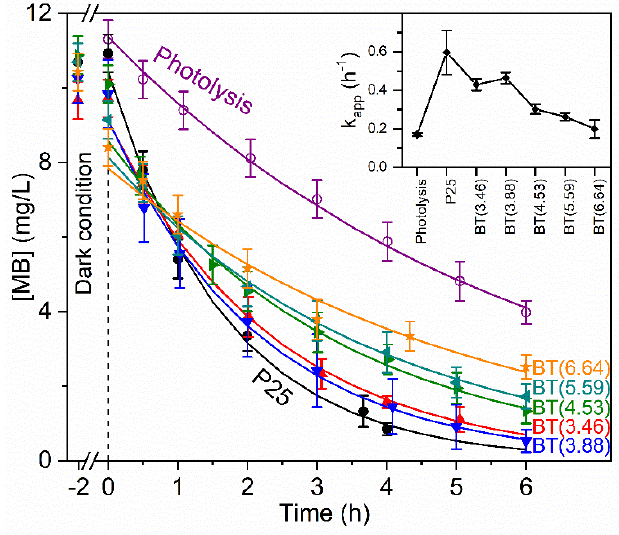
Figure 9. Kinetic curves of photolysis and photocatalytic degradation of methylene blue. Experimental measurements are in symbols and adjustments to kinetic models are in lines. (Inset) Values of the apparent rate constant (k app ).